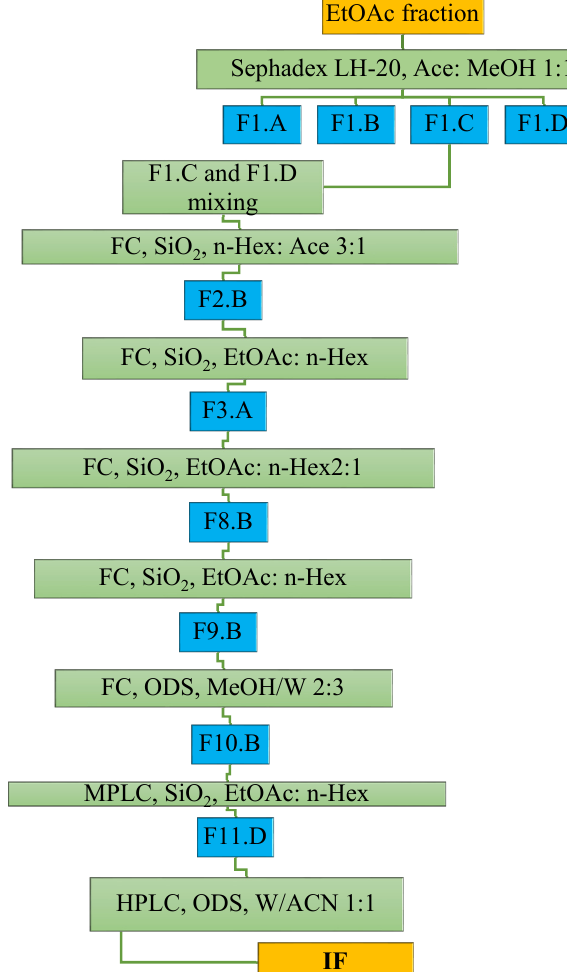
Figure 2. The procedure of Saposhnikovia root fractionation to isolate IF. F: fraction, EtOAc: ethyl acetate, Ace: acetone, MeOH: methanol, W: water, FC: flash chromatography, SiO 2 : Silica gel